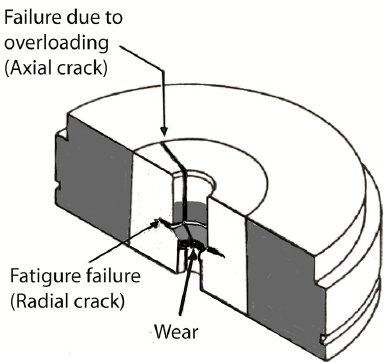
Figure 3. Typical locations of failures and their location in a die after ref. [3].